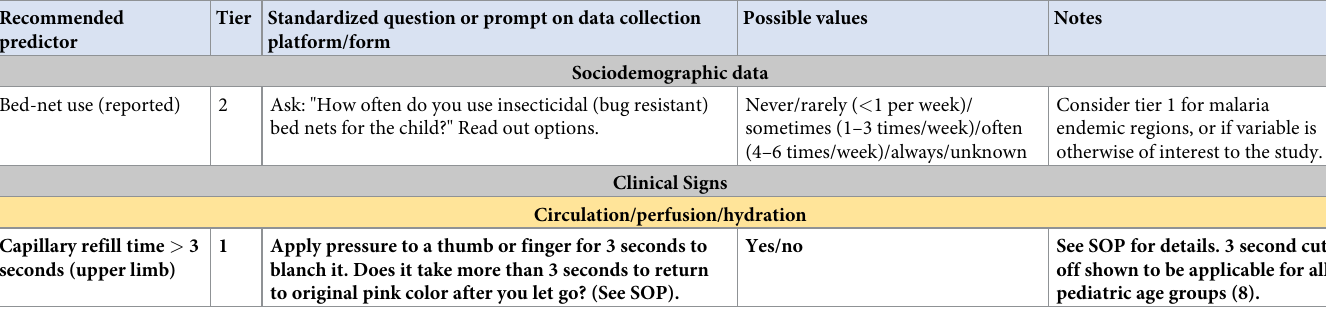
Table 2. Sample predictors as presented in the common data element guidelines. Recommended